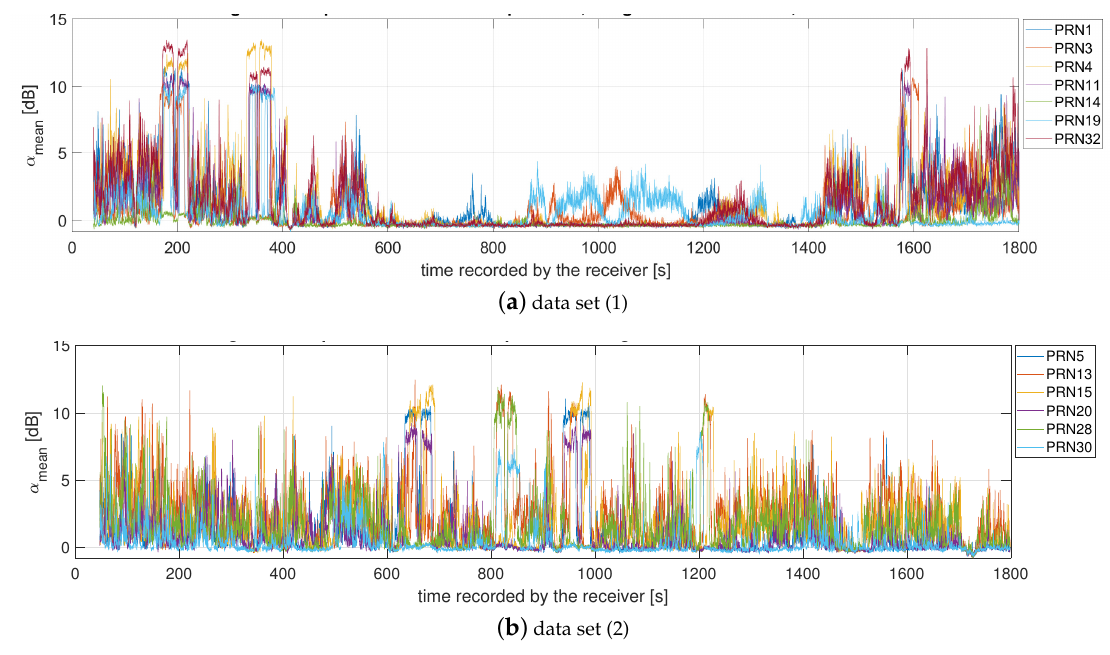
Figure 4. Peak-to-noise-floor separation α mean of the reflected signal for a subset of visible GPS satellites during ( a ) flight (1) December 2013 and ( b ) flight (2) May